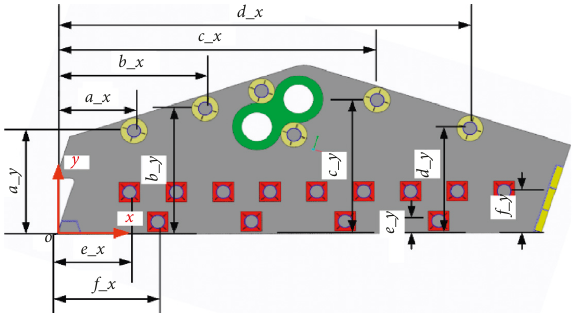
Figure 9: Schematic diagram of design variable for the vibrating screen.